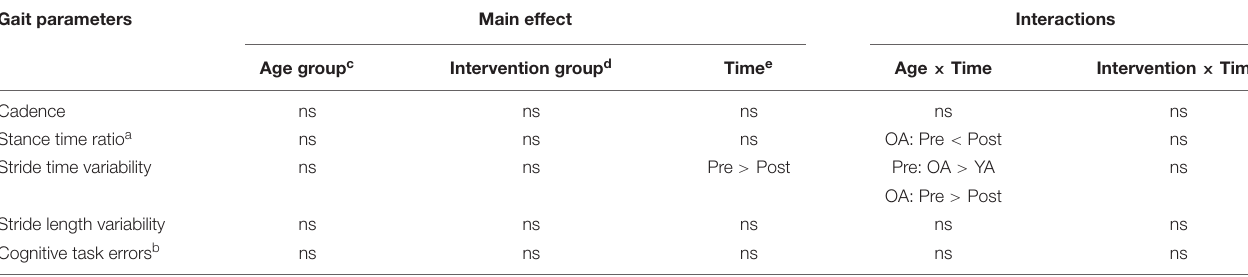
TABLE 3 | Summary of main effect and interactions in 3-way linear mixed models analyses of gait parameters. Gait parameters